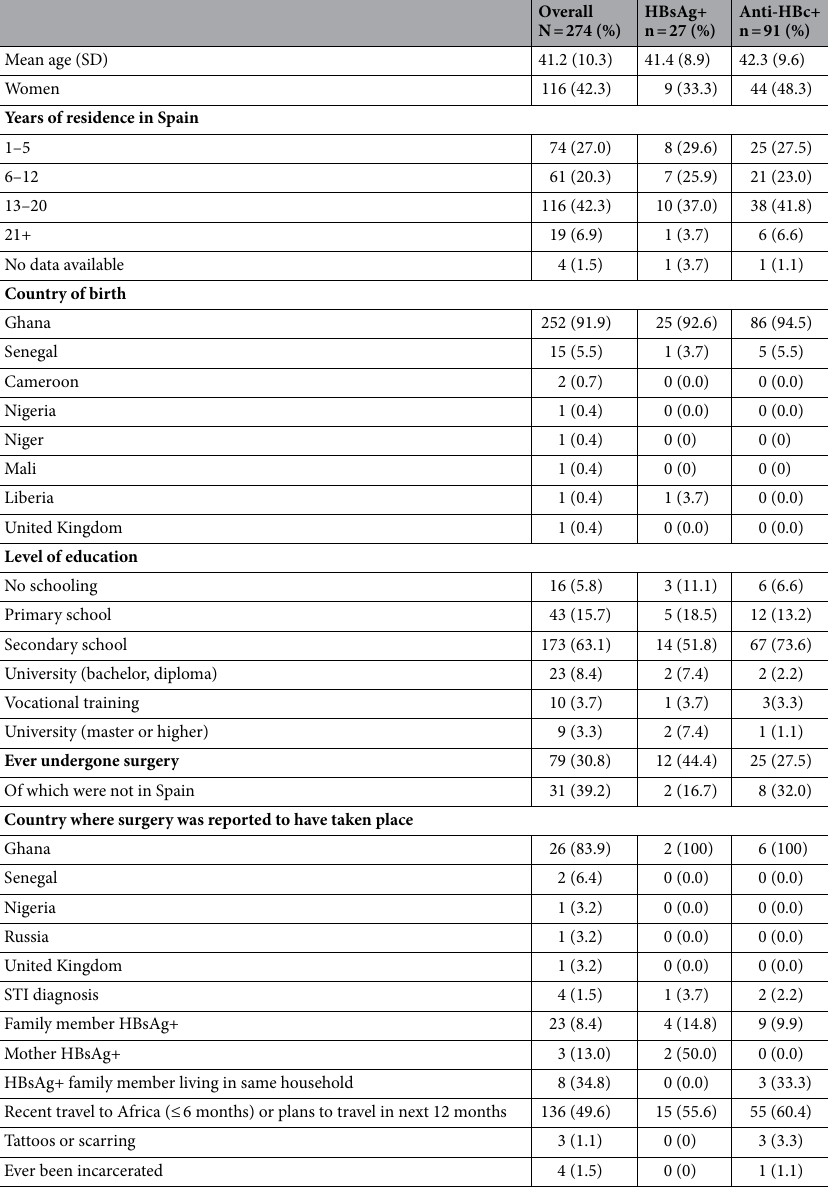
Table 1. Baseline sociodemographic characteristics and risk factors of all patients screened and those who are HBsAg and anti-HBc positive.